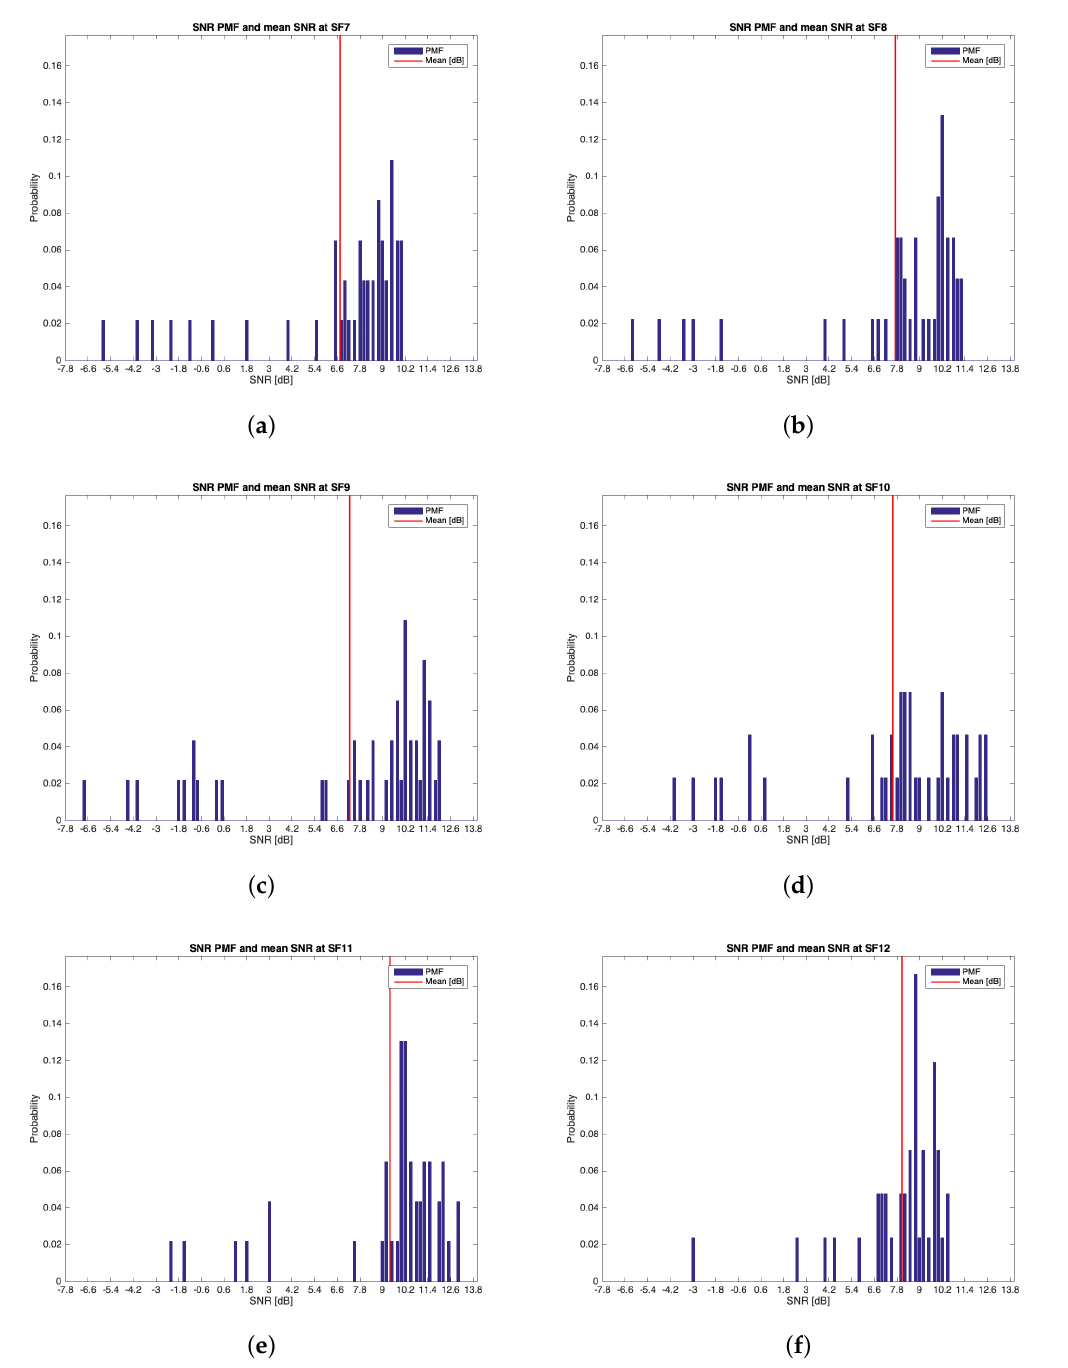
Figure 16. Group #2 SNRs PMFs: ( a ) SF = 7; ( b ) SF = 8; ( c ) SF = 9; ( d ) SF = 10; ( e ) SF = 11; ( f ) SF =